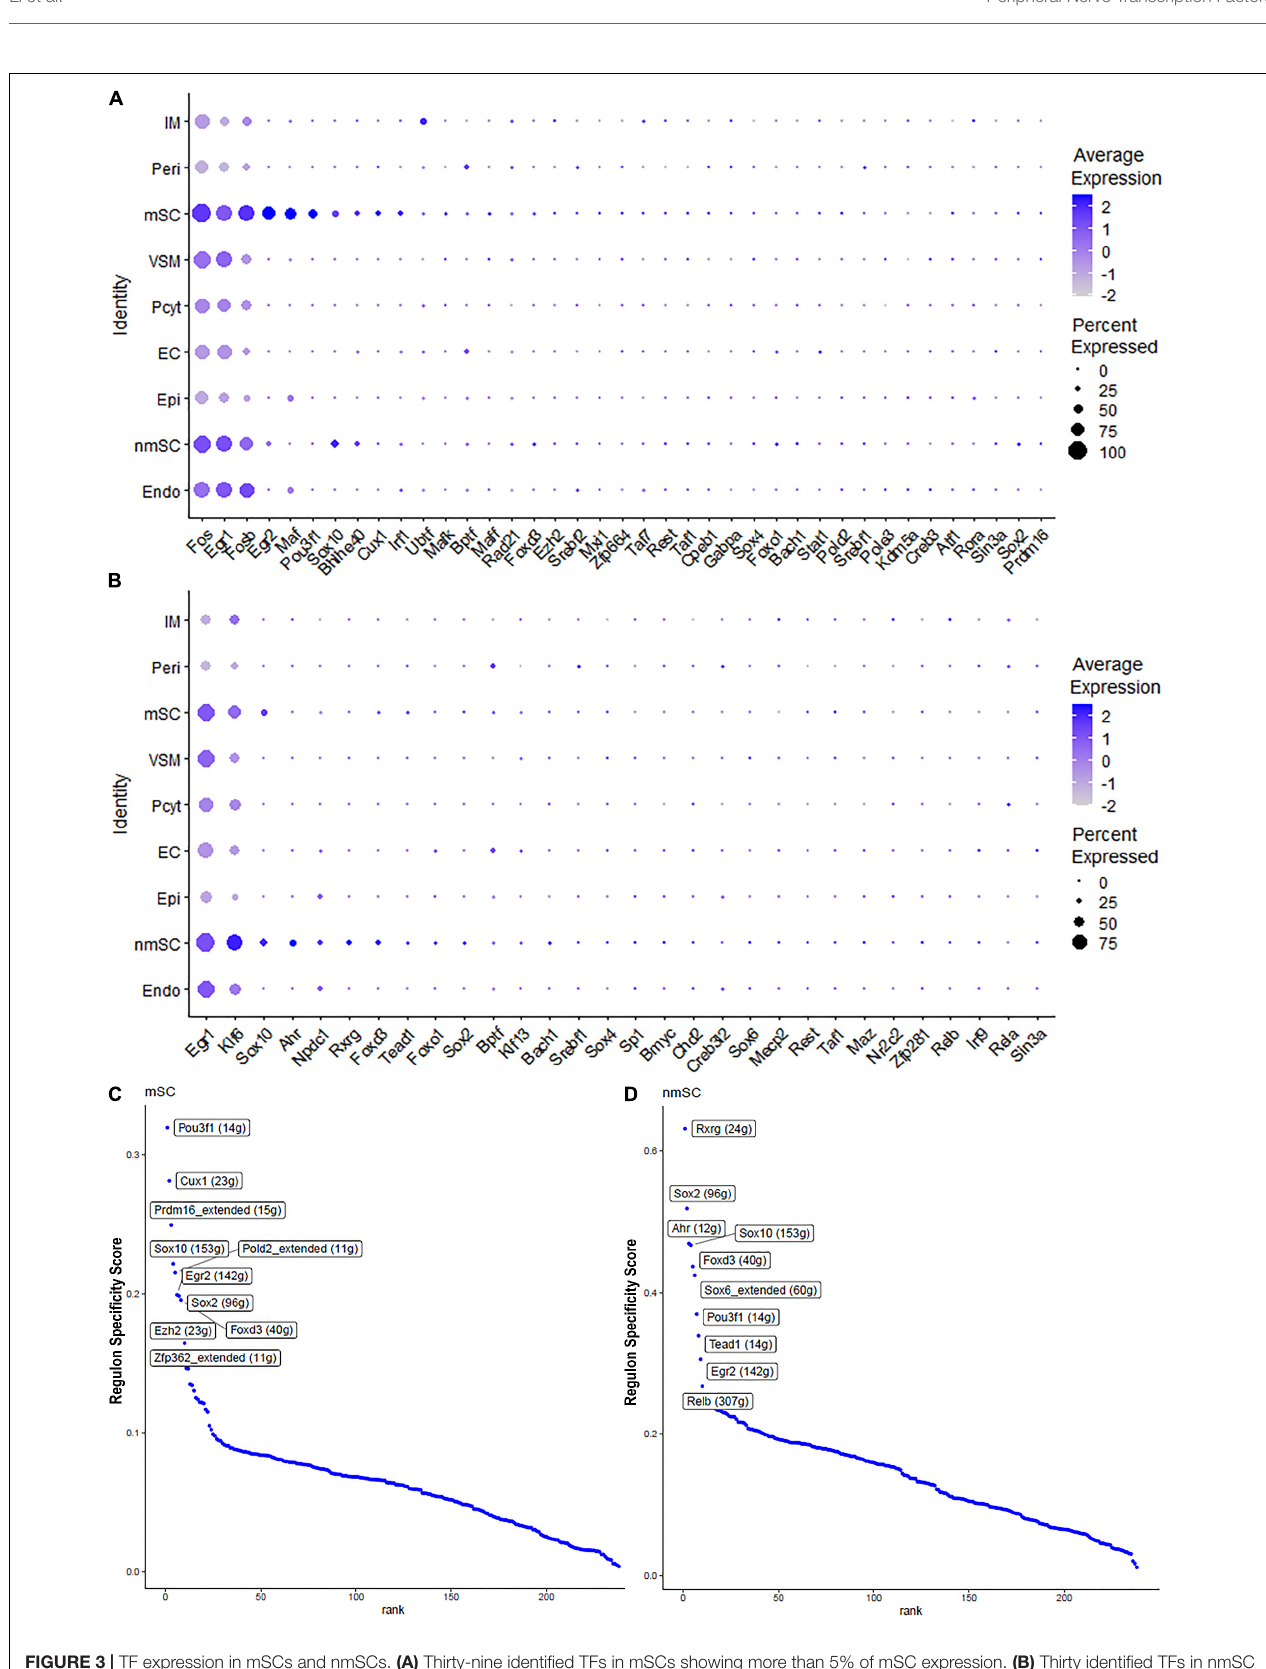
Frontiers in Cellular Neuroscience |